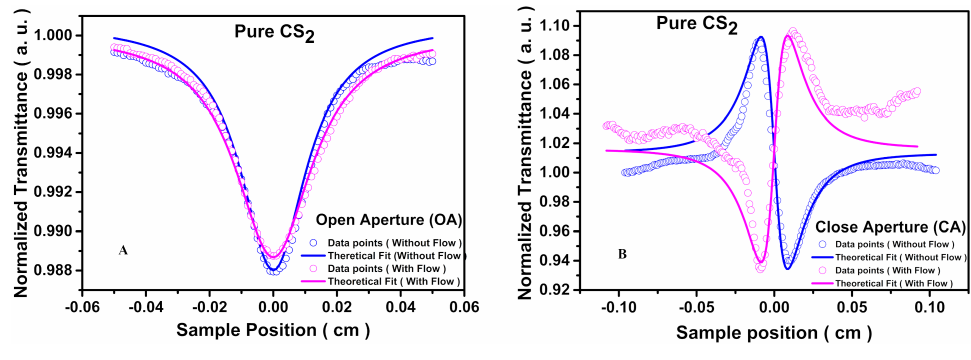
Figure 2 Plot of open aperture z-scan (OAZS). Z-scan data plots of OAZS for the pure carbon disulfide (CS 2 ) liquid under both with-flow and without-flow experimental conditions.